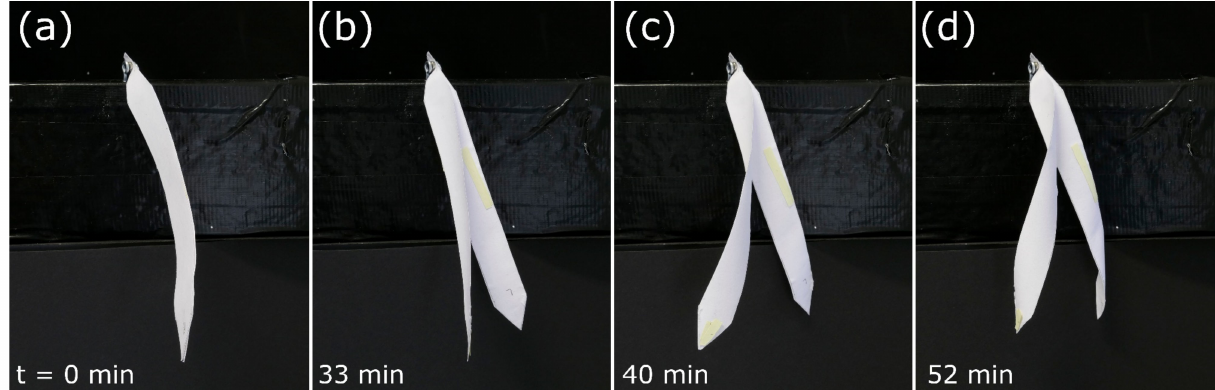
Figure 15. Self-actuated paper-based compliant system inspired by the legume (Fabaceae seed pod) performing rapid opening (at t = 33 min) ( a , b ) and continuous opposite-handed twisting of the valves during desiccation ( b – d ). Times are indicated bottom left.